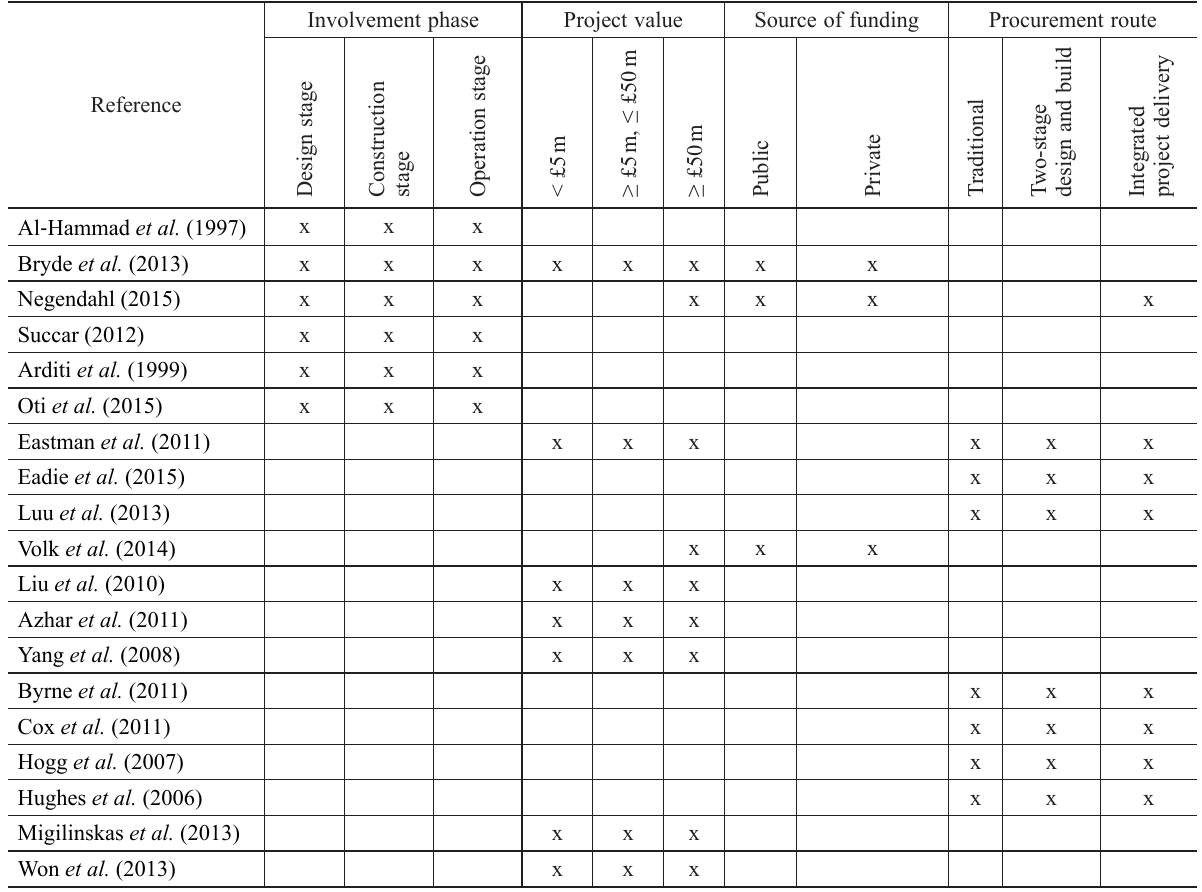
Table 1. Key factors affecting BIM adoption